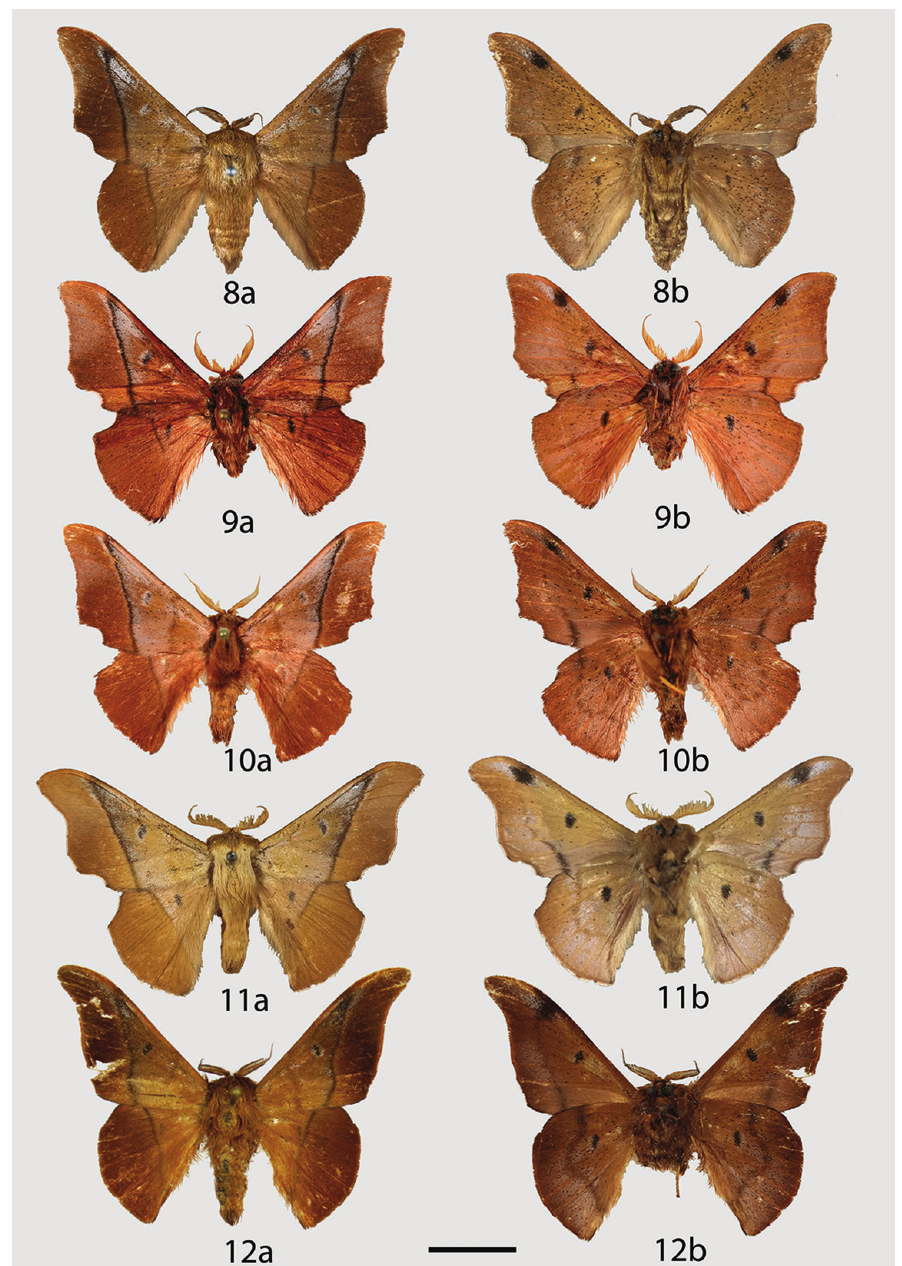
Figures 8–12. Reinmara adults, a dorsal b ventral. 8 R. atlantica Holotype ♂ , Brazil, Espírito Santo, Linhares, 40 m (DZUP) 9 R. andensis Holotype ♂ , Bolivia, N. Yungas, 1000–1800 m (MNHN) 10 R. andensis Paratype ♂ , Locality as for Fig. 9 (CDH) 11 R. andensis Paratype ♂ , Peru, Puno, Oroya, Río Inambari, 3100 ft (NHMUK) 12 R. occidentalis Holotype ♂ , Ecuador, El Oro, 10 km NW Piñas, 750 m (MWM). Scale bar: 1